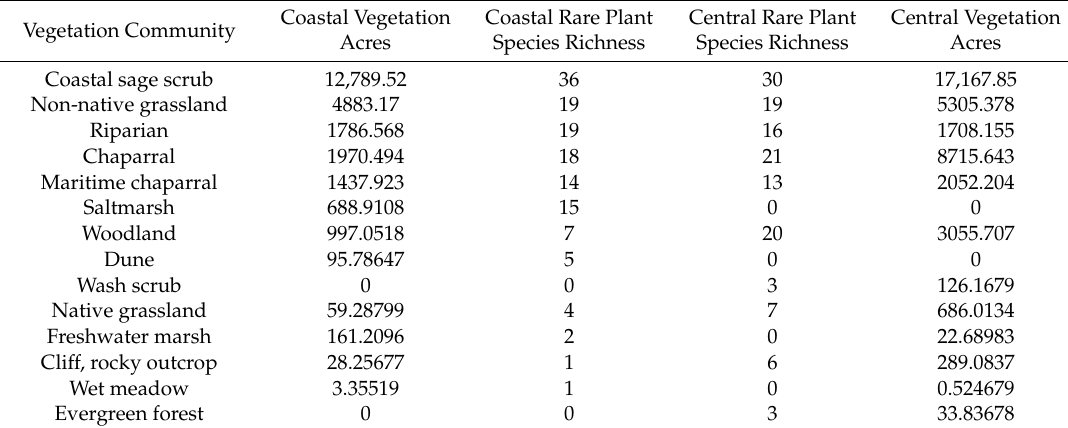
Table A7. Coastal and central reserve rare species richness by vegetation community.